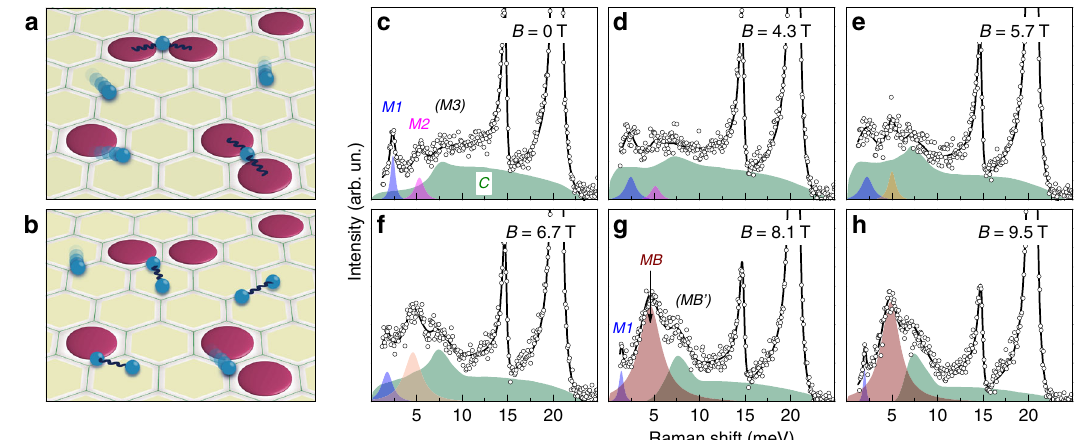
Fig. 2 Magnetic excitations at intermediate magnetic fi elds. a The creation of a bound state from itinerant fermions bound to localized fl uxes and b from binding only itinerant Majorana fermions. c – h Evolution of Raman data obtained at T = 2 K (open circles) with increasing fi elds from 0 to 9.5 T. The shaded regions denote the decomposition of the magnetic excitations into well-de fi ned peaks and a continuum of excitations. The solid line is a sum of all excitations. The M1 (blue) and M2 (purple shading) modes at low fi elds of 0 – 4.3 T correspond to spin-wave excitations. The mode ( M3 ) may be a higher- energy branch of magnon excitations. The excitation MB (dark red) above the critical fi eld of 6.7 T is assigned to a Majorana bound state. The shoulder ( MB ’ ) is either another Majorana bound state or a van-Hove singularity of the Majorana continuum